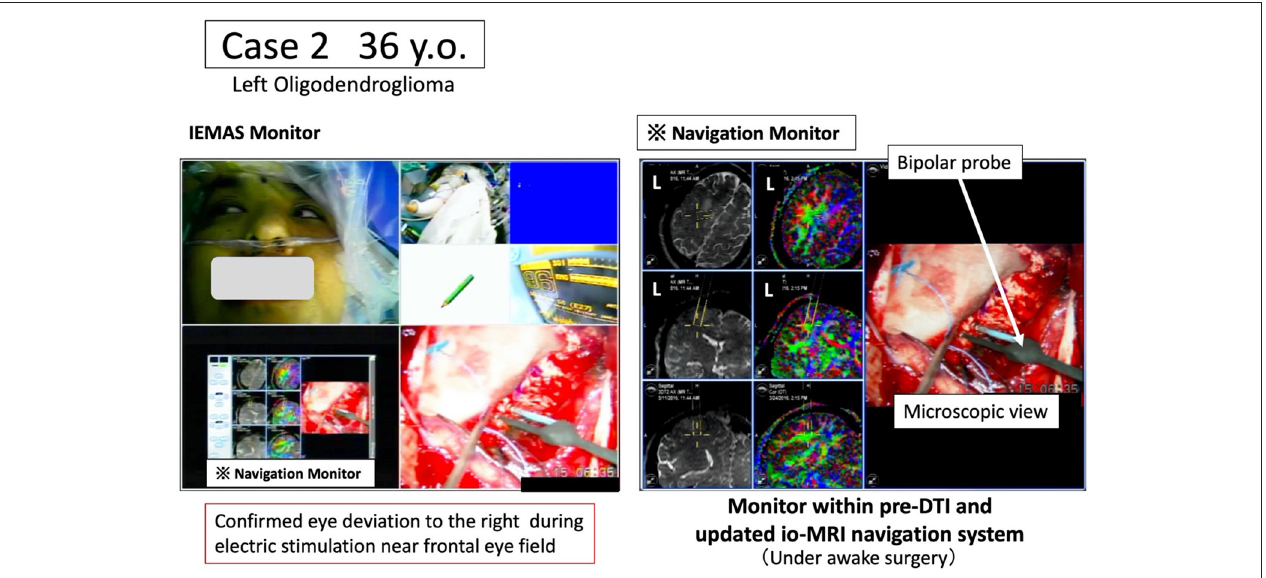
FIGURE 4 | Case 2: pre-operative arcuate fasciculus in which the joint eye movement center is identified based on language function information and language function tests. Under awake craniotomy, the tumor resection is performed while the white matter fiber (green) related to the joint eye movement center is monitored in real time using the newly developed navigation system. The intraoperative language monitoring system (IEMAS) is also used concurrently, and the language reaction associated with the presentation of the language image task is determined by both the surgeon and the examiner, making the system highly useful for awake